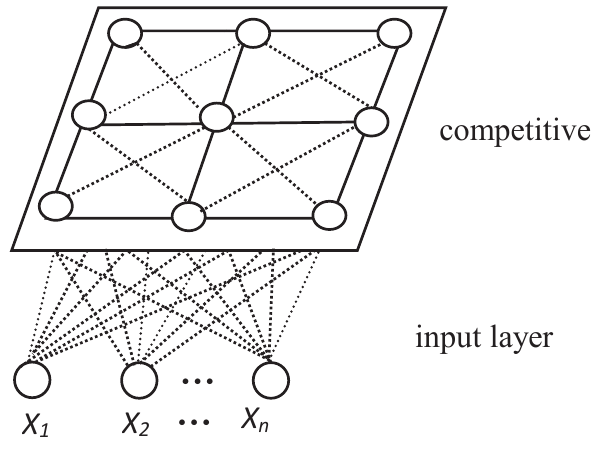
Figure 3. Topology of SOFM neural